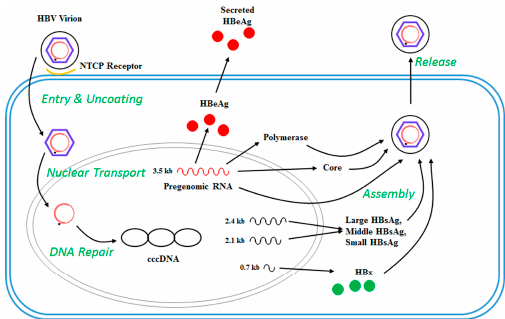
Figure 2. HBV Life Cycle. HBV uses the Sodium Taurocholate Co-transporting Polypeptide (NTCP) receptor to attach to hepatocytes. After entry, HBV nucleocapsids transport the HBV DNA to the nucleus, where the relaxed circular DNA is converted into covalently closed circular (ccc) DNA. The cccDNA assumes a minichromosome-like structure and acts as the template for transcription of four viral RNAs (0.7 kb, 2.1 kb, 2.4 kb and 3.5 kb). The mRNA transcripts are exported to the cytoplasm and used for translation of the HBV proteins. The longest (pre-genomic) RNA also functions as the template for replication, which occurs within nucleocapsids in the cytoplasm. Nucleocapsids are enveloped during their passage through the endoplasmic reticulum (ER) and/or Golgi complex and secreted from the cell. HBeAg: Hepatitis B e antigen; HBsAg: Hepatitis B surface antigen, HBx: Hepatitis B X